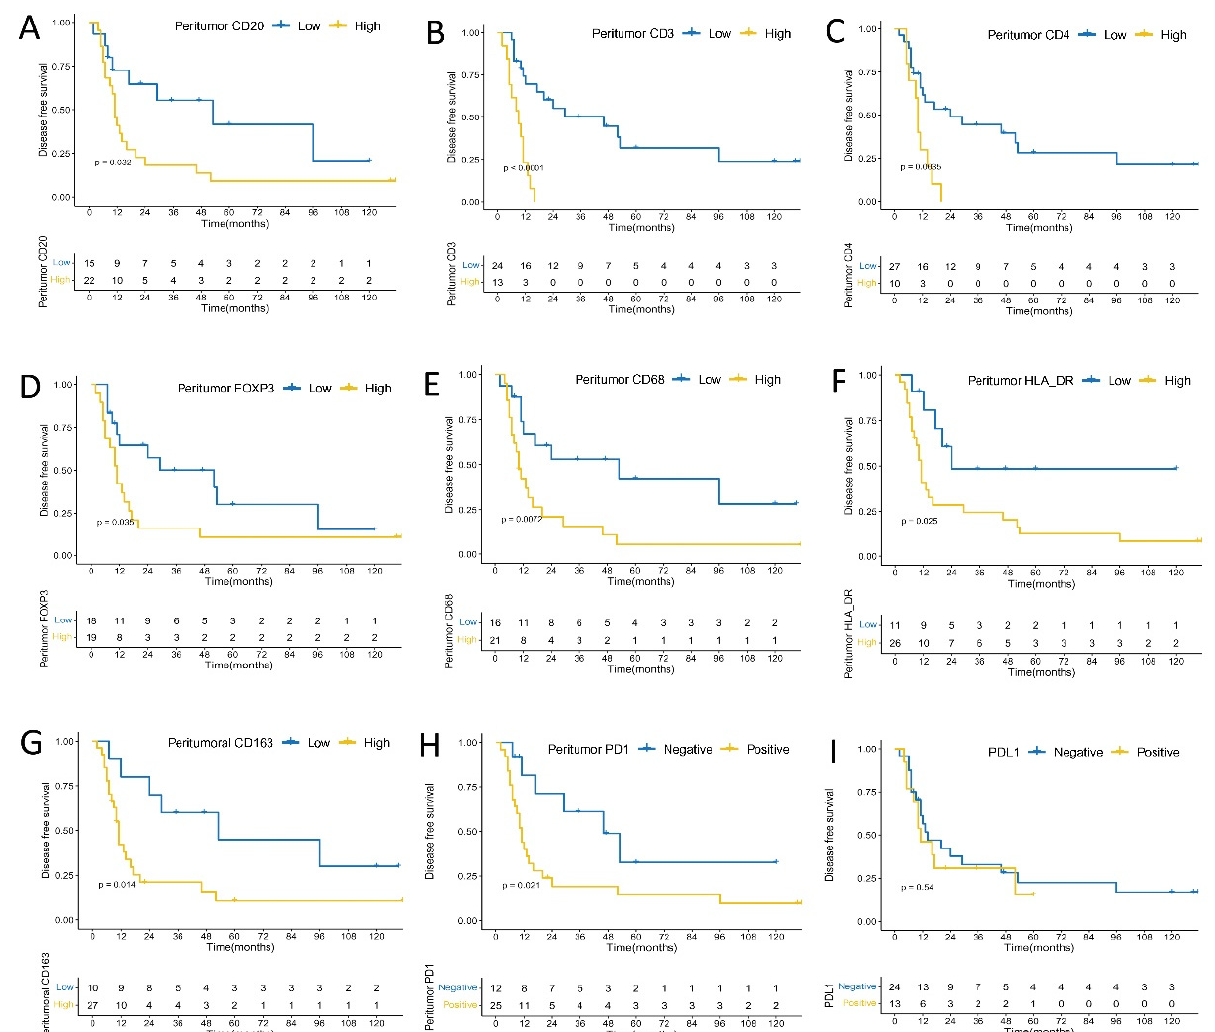
Figure 4. Kaplan–Meier analysis of peritumoral immune cells, PDL1 expression on immune cells and disease free survival. ( A ) CD20; ( B ) CD3; ( C ) CD4; ( D ) FOXP3; ( E ) CD68; ( F ) HLA-DR; ( G ) CD163; ( H ) PD1; ( I ) PD-L1 expression.